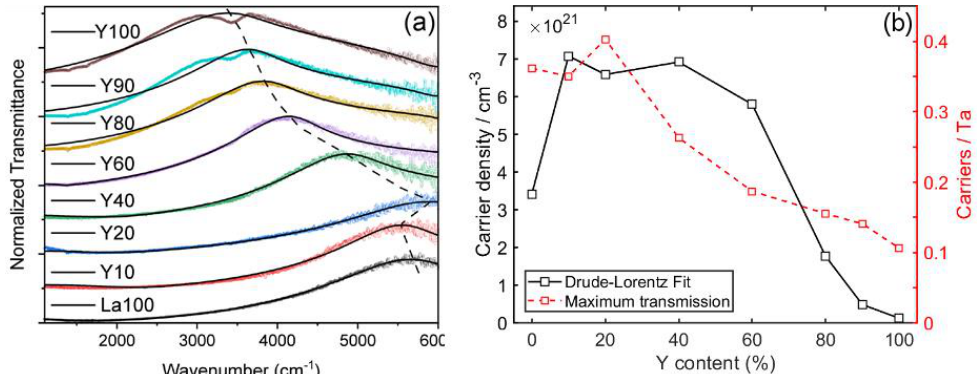
Figure 8. ( a ) Normalized transmission spectra of (Y x La 1−x )S-TaS 2 compounds with varying proportions of yttrium (Y40 stands for (Y 0.4 La 0.6 )S-TaS 2 ). The solid lines represent the fitted Drude-Lorentz model. The dashed line (guide to the eye) indicates the non-linear shift of the transmittance in the spectra. ( b ) The variation of the carrier density and carriers per Ta atom calculated from the Drude-Lorentz model (black curve) and separately from the maximum transmissivity model (dashed red curve) as a function of Y at% in the (Y x La 1−x )S-TaS 2 misfit compound. Adopted from [31] with ACS permission.